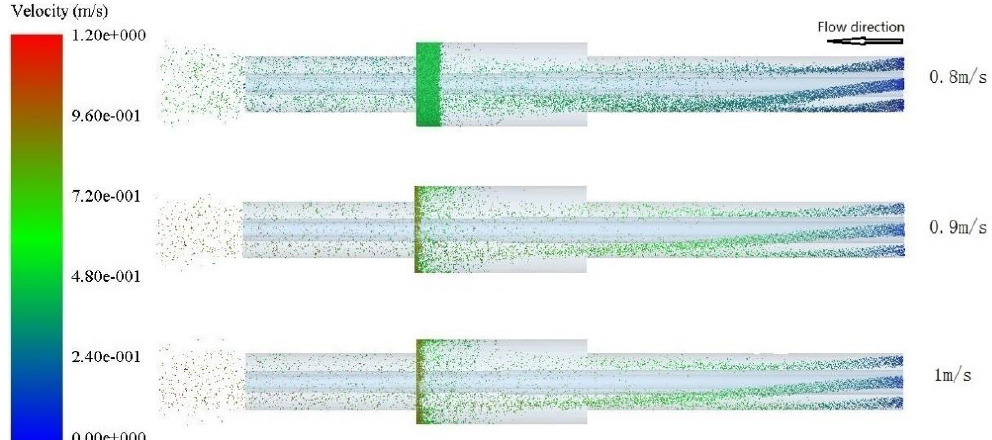
Figure 4. Particle distribution map after 10 s simulation time with different velocity under right-angle expansion.